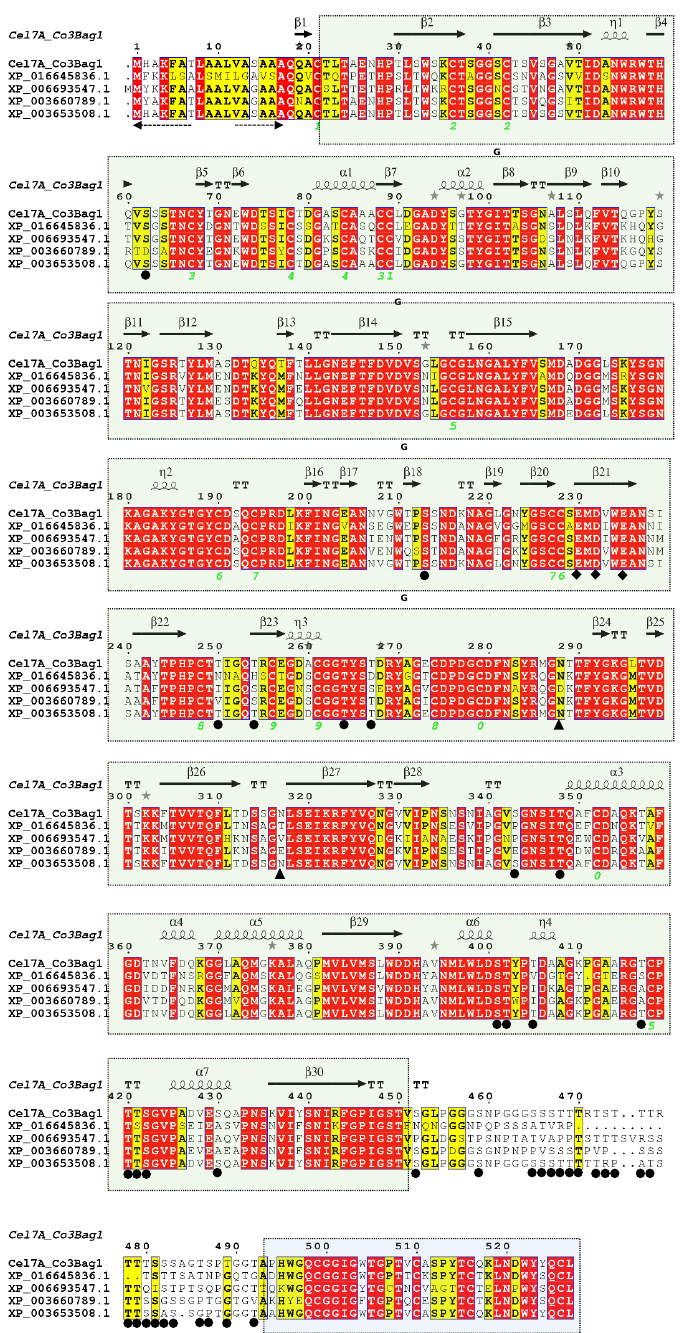
Figure 10. Multiple sequence alignment and secondary structure of TtCel7A and other enzymes. Sequence alignment of two GH7 enzymes from Thermothielavioides terrestris NRRL 8126 (XP_003653508.1) and Thermothelomyces thermophilus ATCC 42464 (XP_003660789.1) and two exoglucanases from Scedosporium apiospermum (XP_016645836.1) and Chaetomium thermophilum var. thermophilum DSM 1495 (XP_006693547.1). For the secondary structure of TtCel7A, β -strands and α -helices were based on the 3D crystal structure of the thermostable cellobiohydrolase Cel7A from the fungus Humicola grisea var. thermoidea . Strictly conserved residues are seen in the red box and similar residues in the yellow box. The catalytical residues Glu230, Asp232, and Glu235 are represented with diamonds. The triangle and circles indicate the probable N- and O-glycosylated sites. The sequence alignment was generated with the ESPript